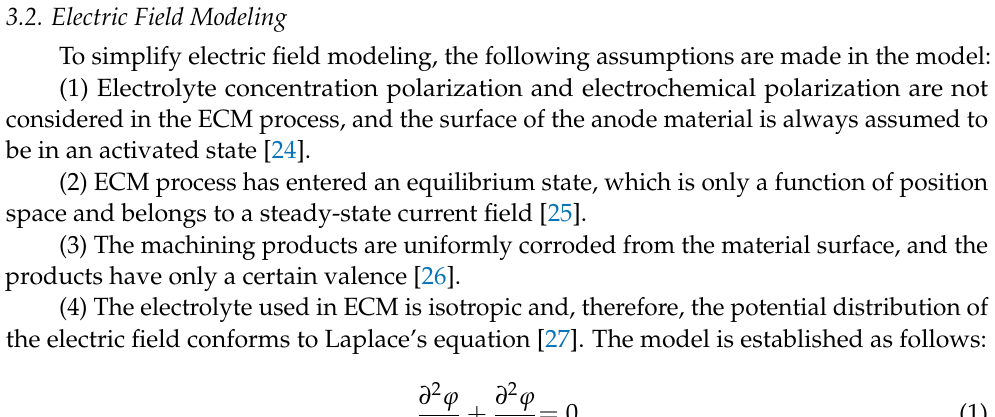
Figure 2. Multi-physical coupling relationship of ECM.